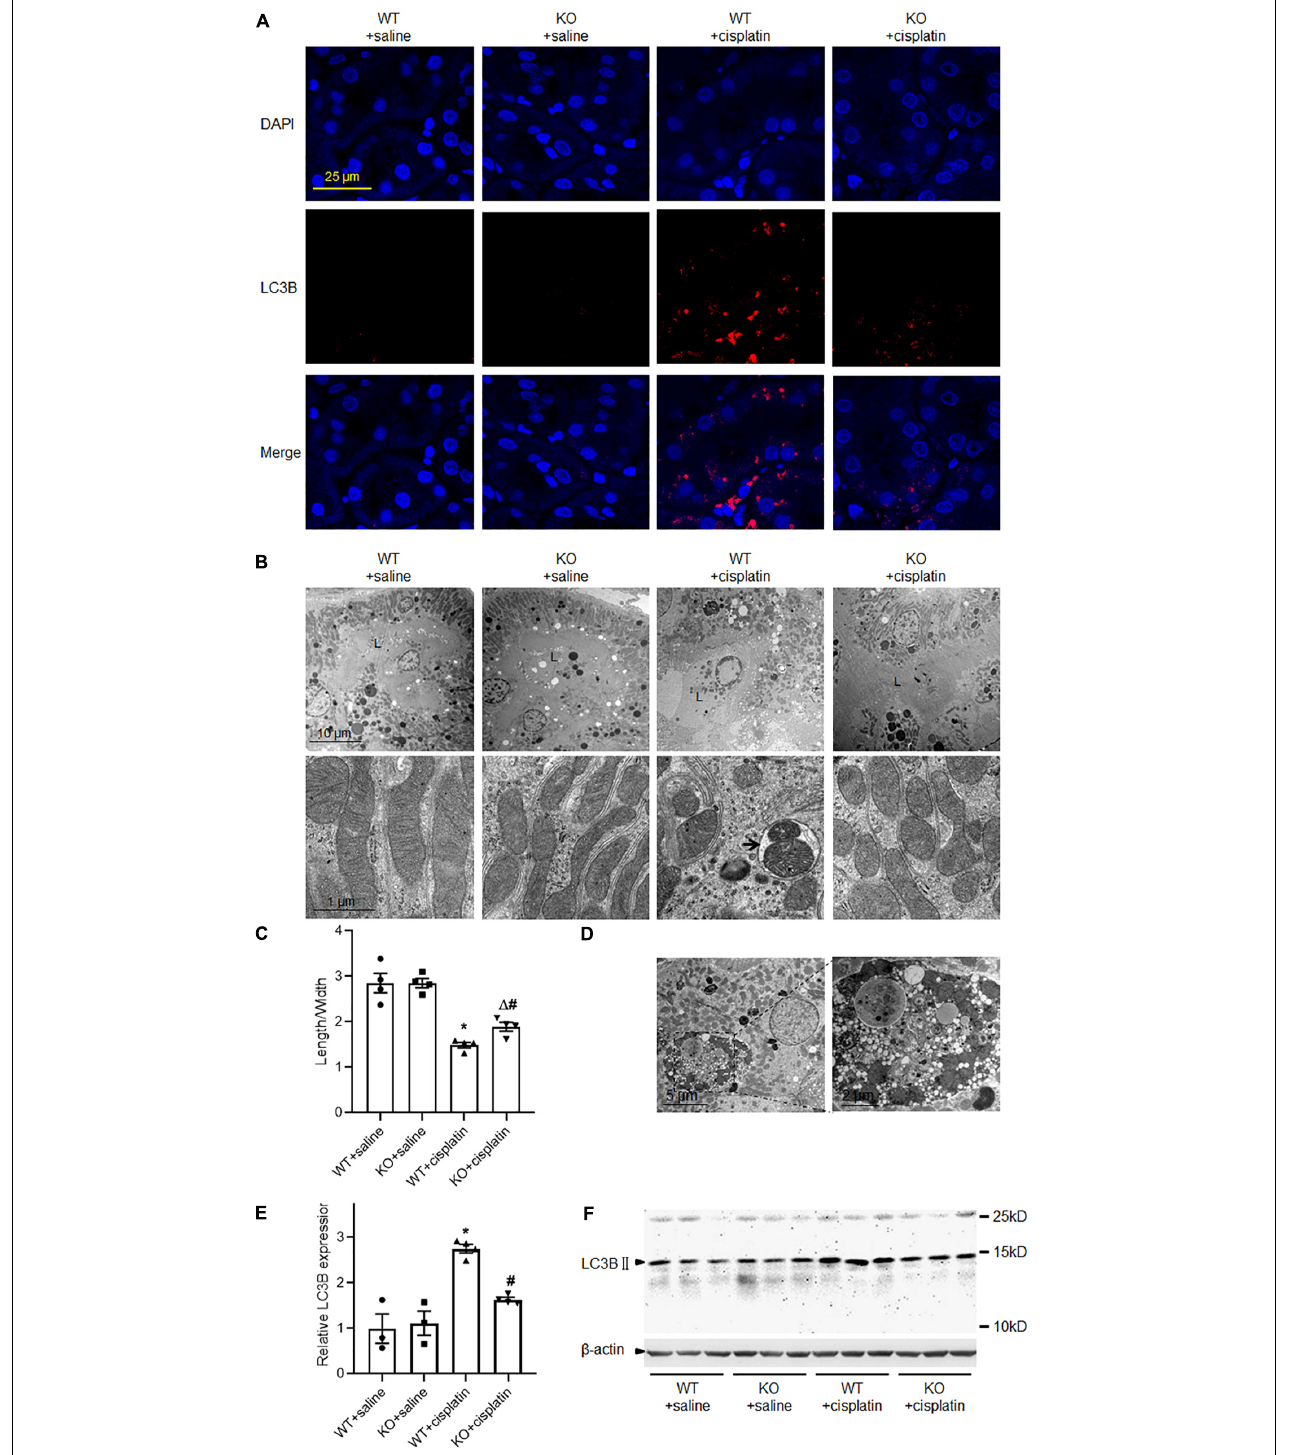
FIGURE 2 | PINK1 deficiency prevented cisplatin-induced mitophagy. (A) Representative images of LC3B immunostaining. (B) Representative transmission electron microscope images of renal proximal tubular cells and mitochondria. L indicated the proximal tubular lumen. The arrow indicated a representative mitophagosome. (C) Quantitative analysis of the length/width of mitochondria in proximal tubular cells. (D) Transmission electron microscope images of large vacuoles containing numerous autophagosomes and mitophagosomes in cisplatin treated WT rats. (E) Quantitative analysis of the western blotting of LC3BII. (F) Representative western blot bands of LC3BII in renal cortex. N = 3 in WT + saline group and KO + saline group, N = 4 in WT + cisplatin group and KO + cisplatin group. ∗ P < 0.05, WT + cisplatin vs. WT + saline; # P < 0.05, KO + cisplatin vs. WT + cisplatin; (cid:49) P < 0.05, KO + cisplatin vs. KO + saline. Data are mean ± SE.